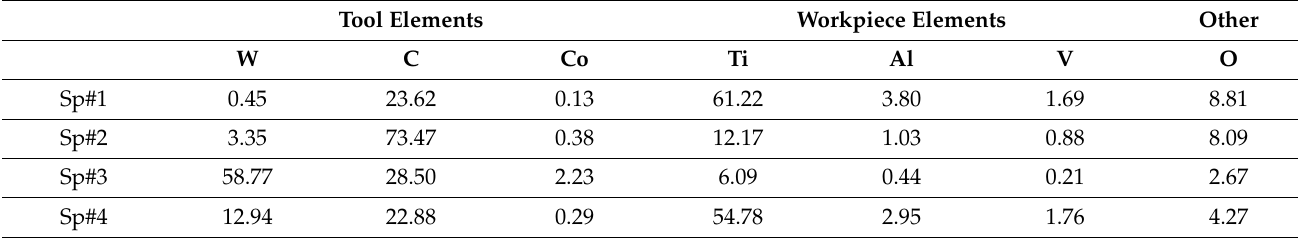
Table 5. EDS Spectral analysis of locations identified in Figure 16d.